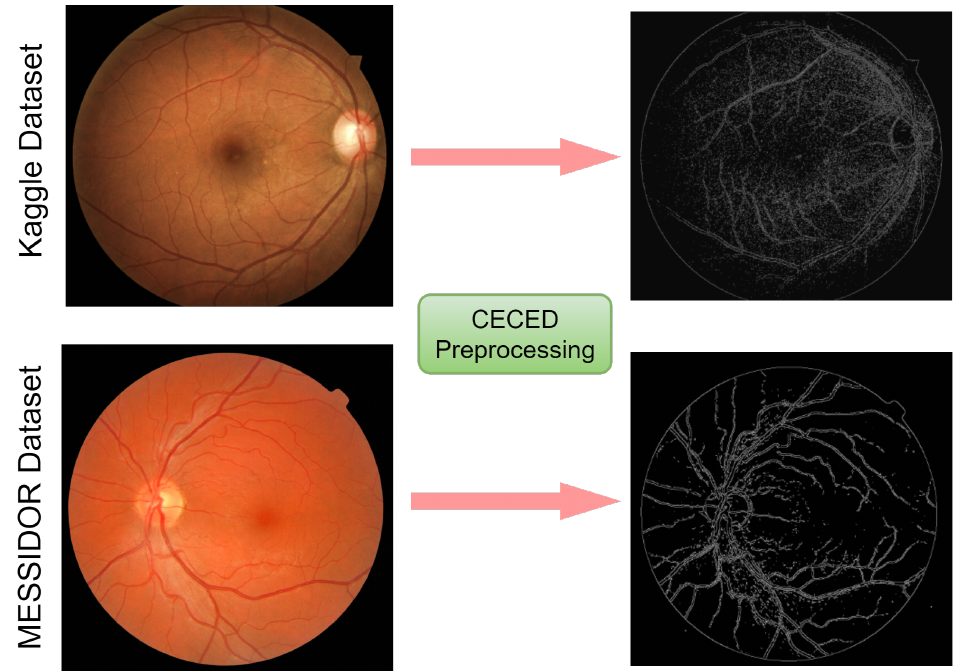
Figure 4. Visual representation of the fundus images from the Kaggle and Messidor datasets. On the left are images before pre-processing, and on the right are images after CECED